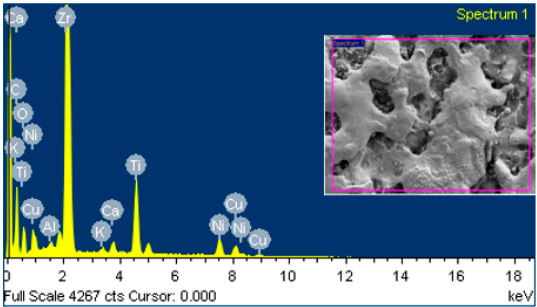
Figure 4. Energy-dispersive X-ray Spectroscopy (EDS) spectrum of the processed Zr 67 Cu 11 Ni 10 Ti 9 Be 3 BMG indicating the presence of major hydroxyapatite elements (Ca, O, and K) on the BMG surface.